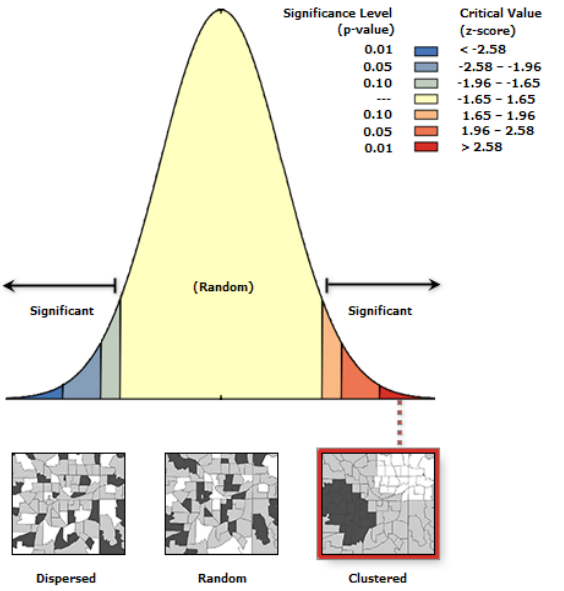
Figure 3. Moran index of CO 2 Emissions in the Yangtze River (mainstream) (2019).